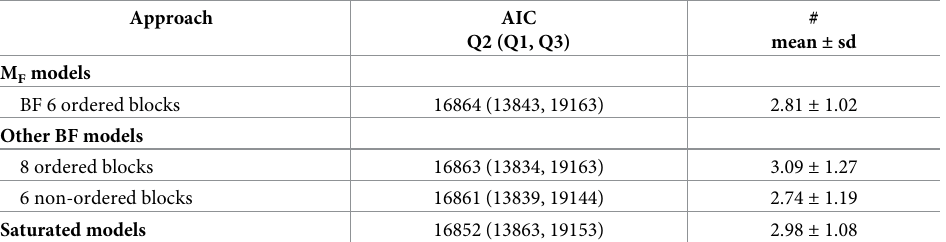
Table 2. AIC and number of significant covariates (#) for the BF based and the saturated models over the 58 loca- tions. The AIC is displayed with distributional quartiles Q1, Q2 (median) and Q3, and # is shown as mean ± standard